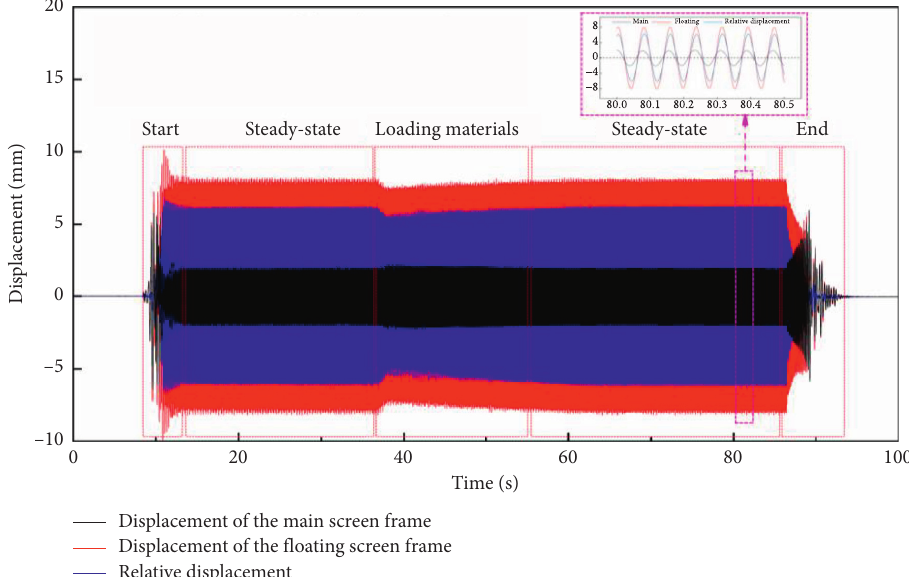
Figure 9: Dynamic response of the displacements of two frames and relative displacement in time domain at the frequency of